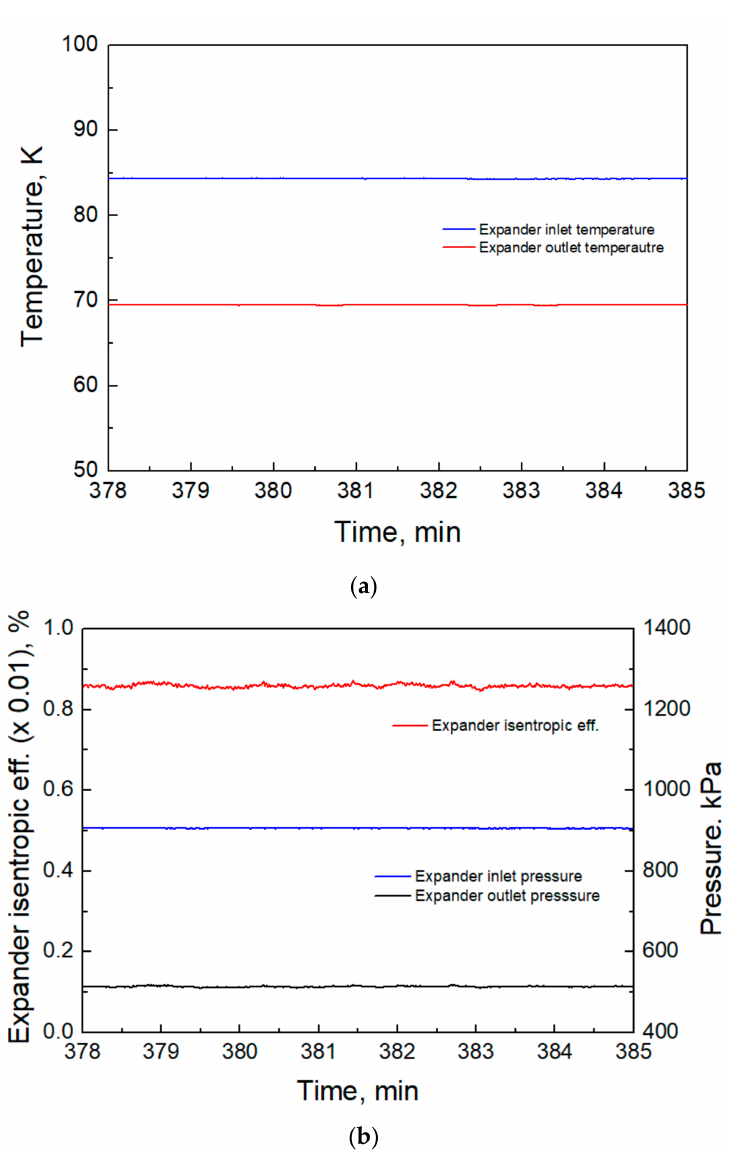
Figure 7. Measurement results of the cryogenic turbo-expander: ( a ) inlet and outlet temperatures of the cryogenic turbo-expander and ( b ) isentropic e ffi ciency and inlet and outlet pressures of the cryogenic